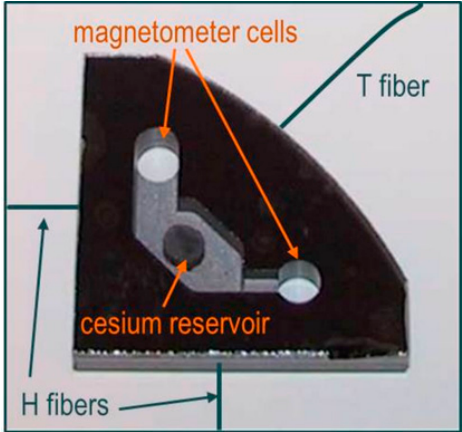
Figure 1. Photograph of an integrated configuration of two magnetometer cells, both connected to a common cesium reservoir. Fibers for heating this cell array (H fibers) and temperature measurement (T fiber) are sketched (reproduced with permission from Schultze [31], copyright 2015 Optical Society of America).